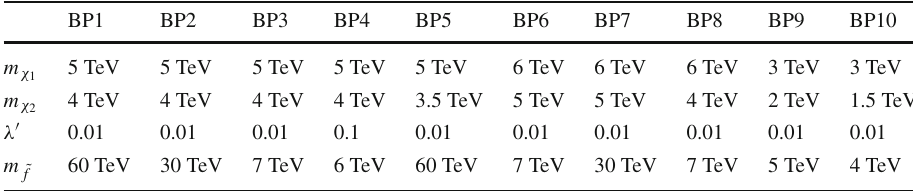
points considered for different plots in Fig. 3d, e